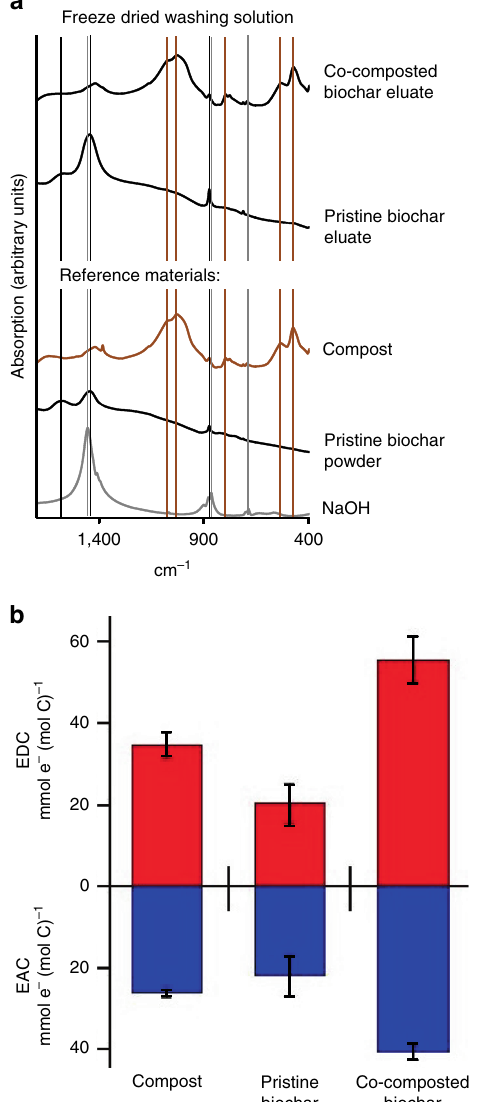
Fig. 6 Ex situ analysis of the organic coating extracted from the biochar with 0.05 M NaOH. a Fourier-transformed infrared (FTIR) spectra of freeze-dried eluates of pristine and co-composted biochar. FTIR spectra of pure compost, pristine biochar and NaOH were measured as a reference. b Electron accepting (blue) and electron donating (red) capacity (EAC and EDC) of biochar eluates normalized to their carbon content. Error bars represent one standard deviation of at least fi ve replicates